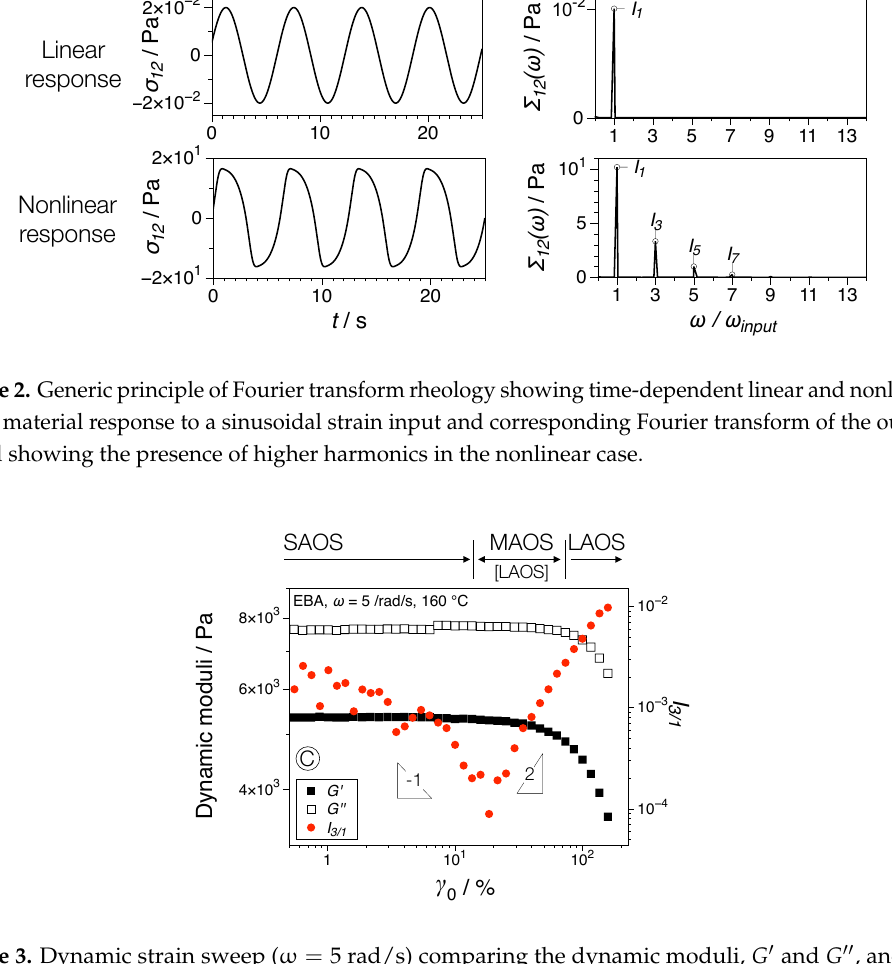
Figure 3. Dynamic strain sweep ( ω = 5 rad/s) comparing the dynamic moduli, G (cid:48) and G (cid:48)(cid:48) , and the relative first higher harmonic, I 3/1 , for poly(ethylene-butyl acrylate) (EBA) at 160 ◦